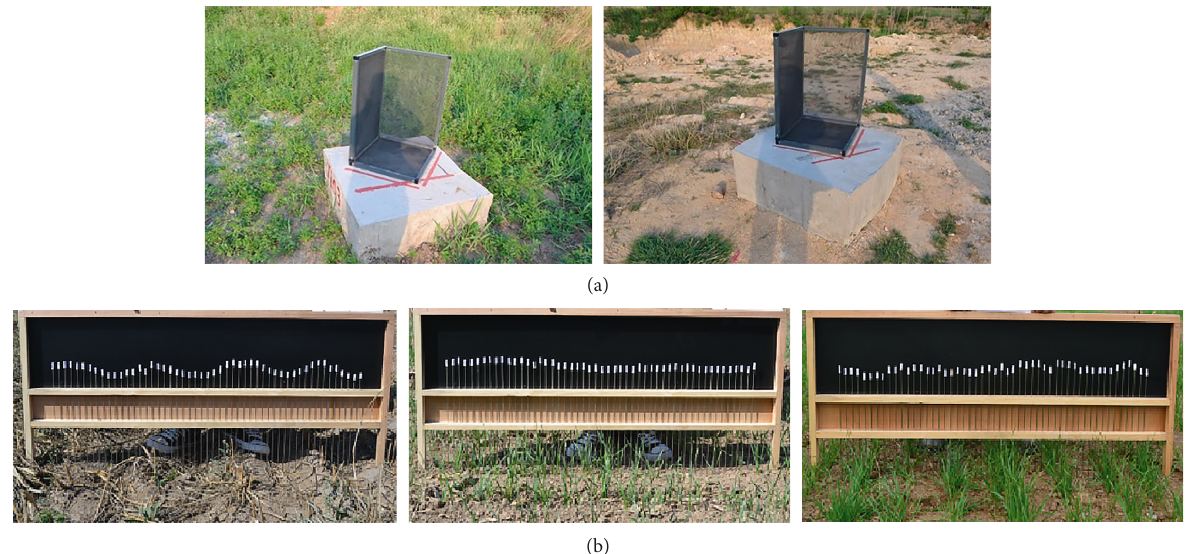
Figure 4: Field photos of the in situ measurements over the study area. (a) Corner reflectors. (b) Surface roughness